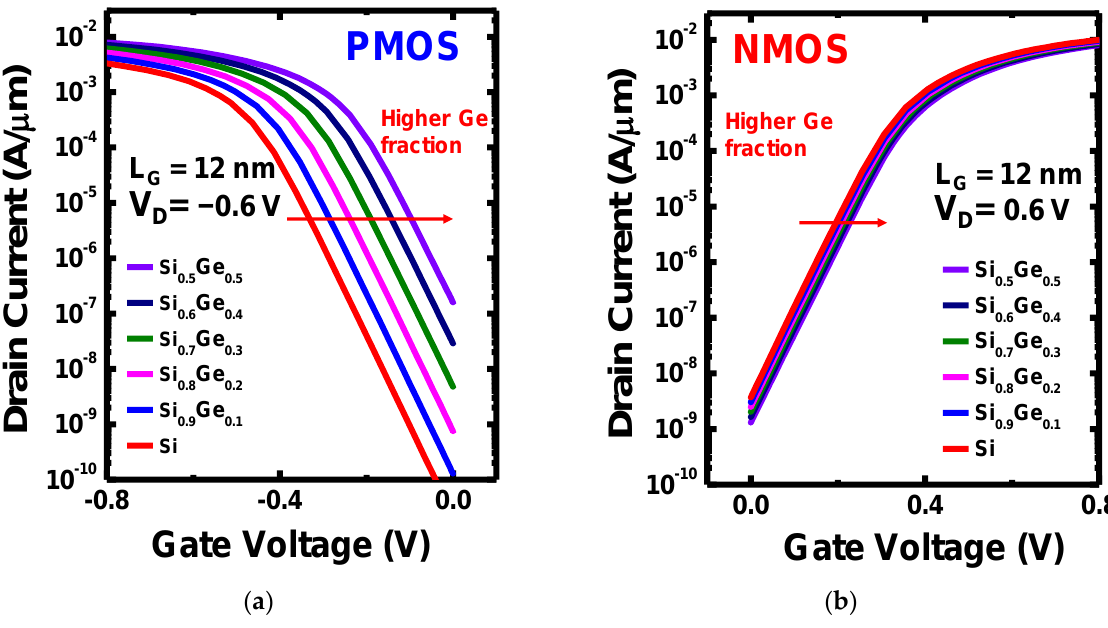
Figure 3. ( a , b ) are I D -V G transfer curves of the PMOS and NMOS, respectively, in CFET structure, with varying Ge mole fraction (x) from 0 to 50%.